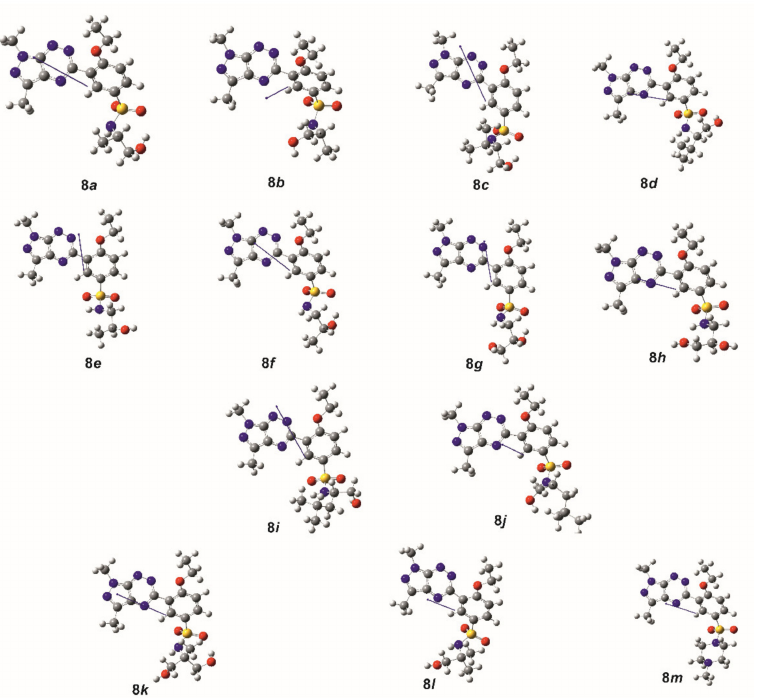
Figure 1. Molecules 8a – m with the vector’s dipole moment in the low-energy conformation obtained from calculations at the DFT/B3LYP/6-311++G(d,p)